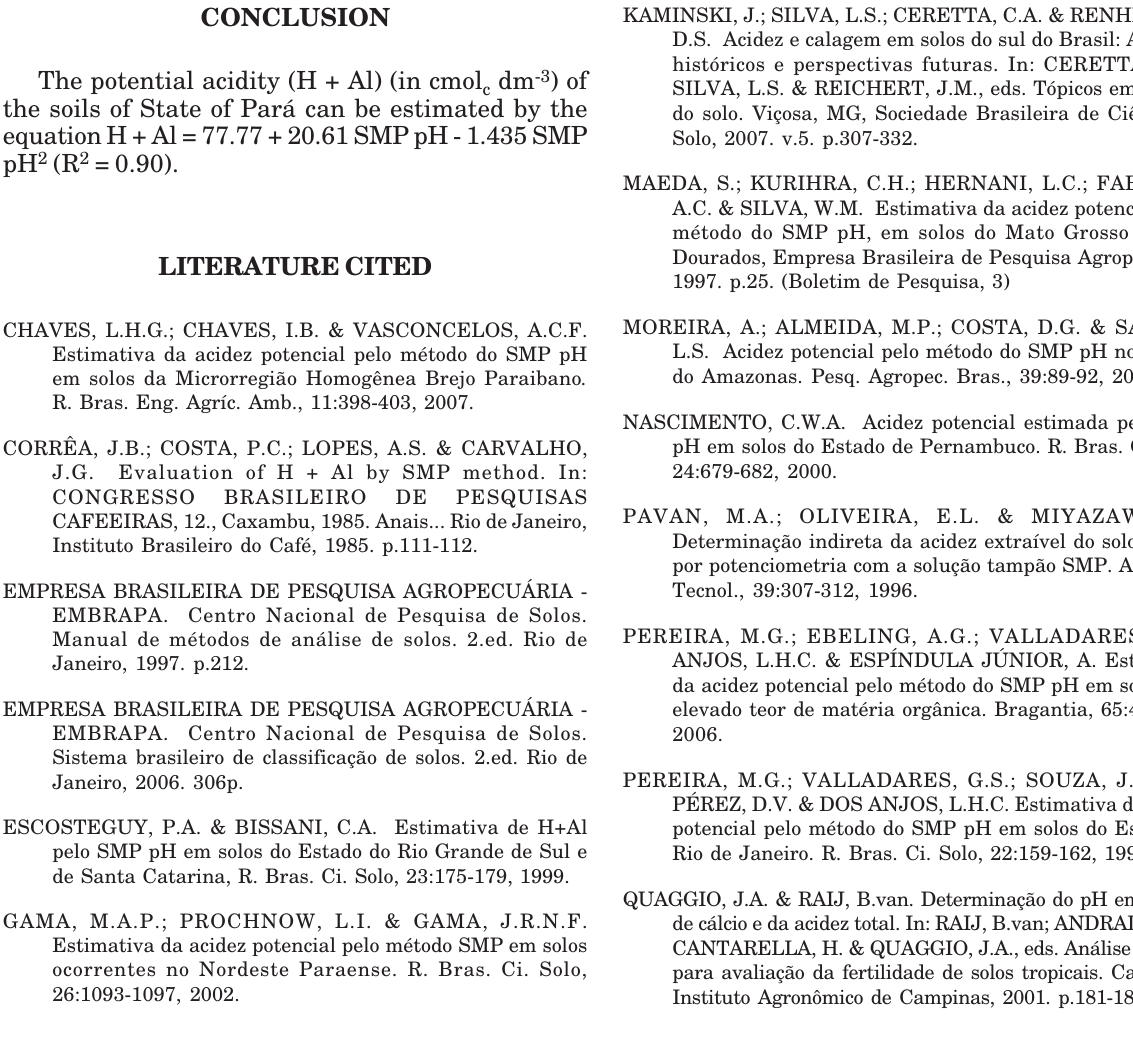
The equations used to estimate H + Al concentrations based on SMP pH were: SP: ln (H + Al) = 7.76 - 1.053 SMP pH; MG: ln (H + Al) = 8.06 - 1.111 SMP pH; Cerrados: ln (H + Al) = 7.719 - 1.068 SMP pH; MS: ln (H + Al) = 8.086 - 1.062 SMP pH; RJ: ln (H + Al) = 7.75 - 1.02 SMP pH; Northeastern Pará: H + Al = 78.63 + 20.173 SMP pH - 1.3294 SMP pH 2 ; Northwestern Paraná: H + Al = 20.1925 - 2.6484 SMP pH; Amazonas